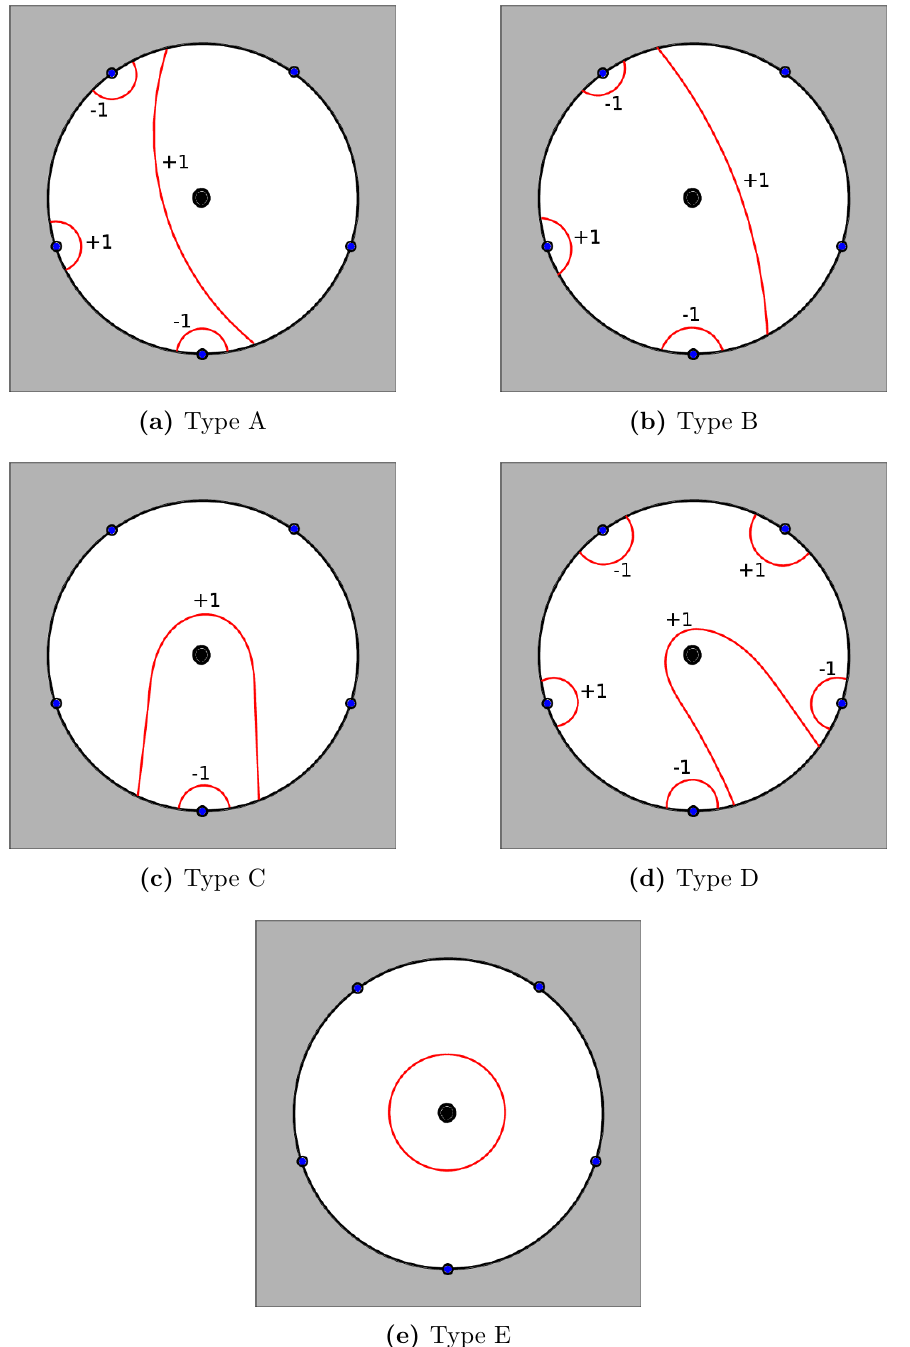
Figure 20. Five types of laminations in ( A 1 ; D 5 ) Argyres-Douglas theory.